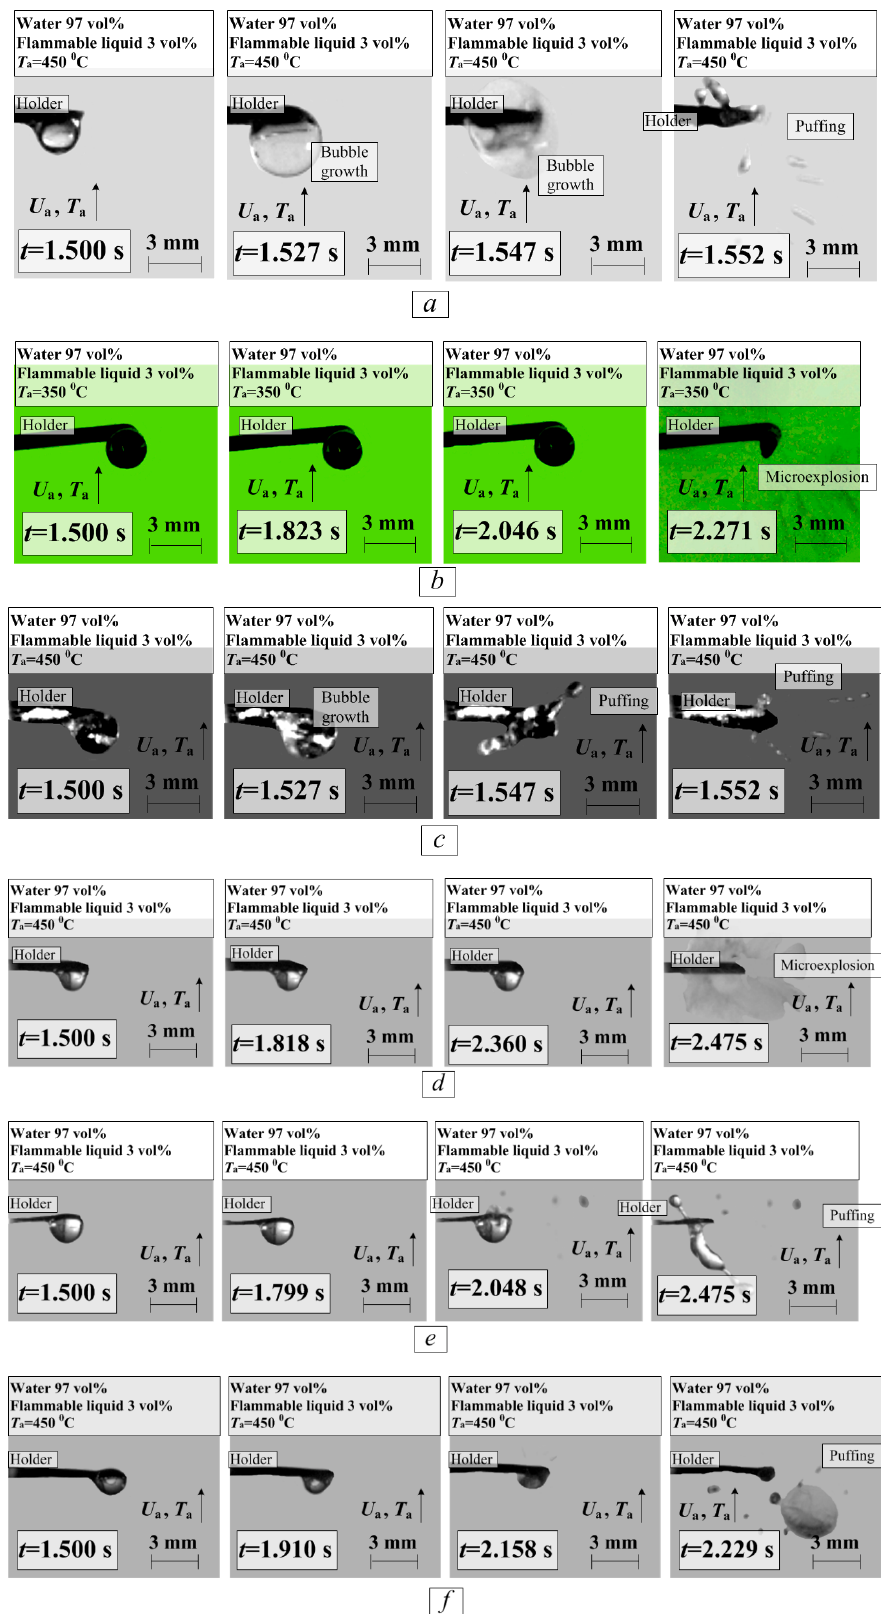
Figure 3. Snapshots of breakup or fragmentation on various holders: ( a ): ceramics; ( b ): steel; ( c ): aluminum; ( d ): steel tube; ( e ): nichrome; ( f ): phosphorus.